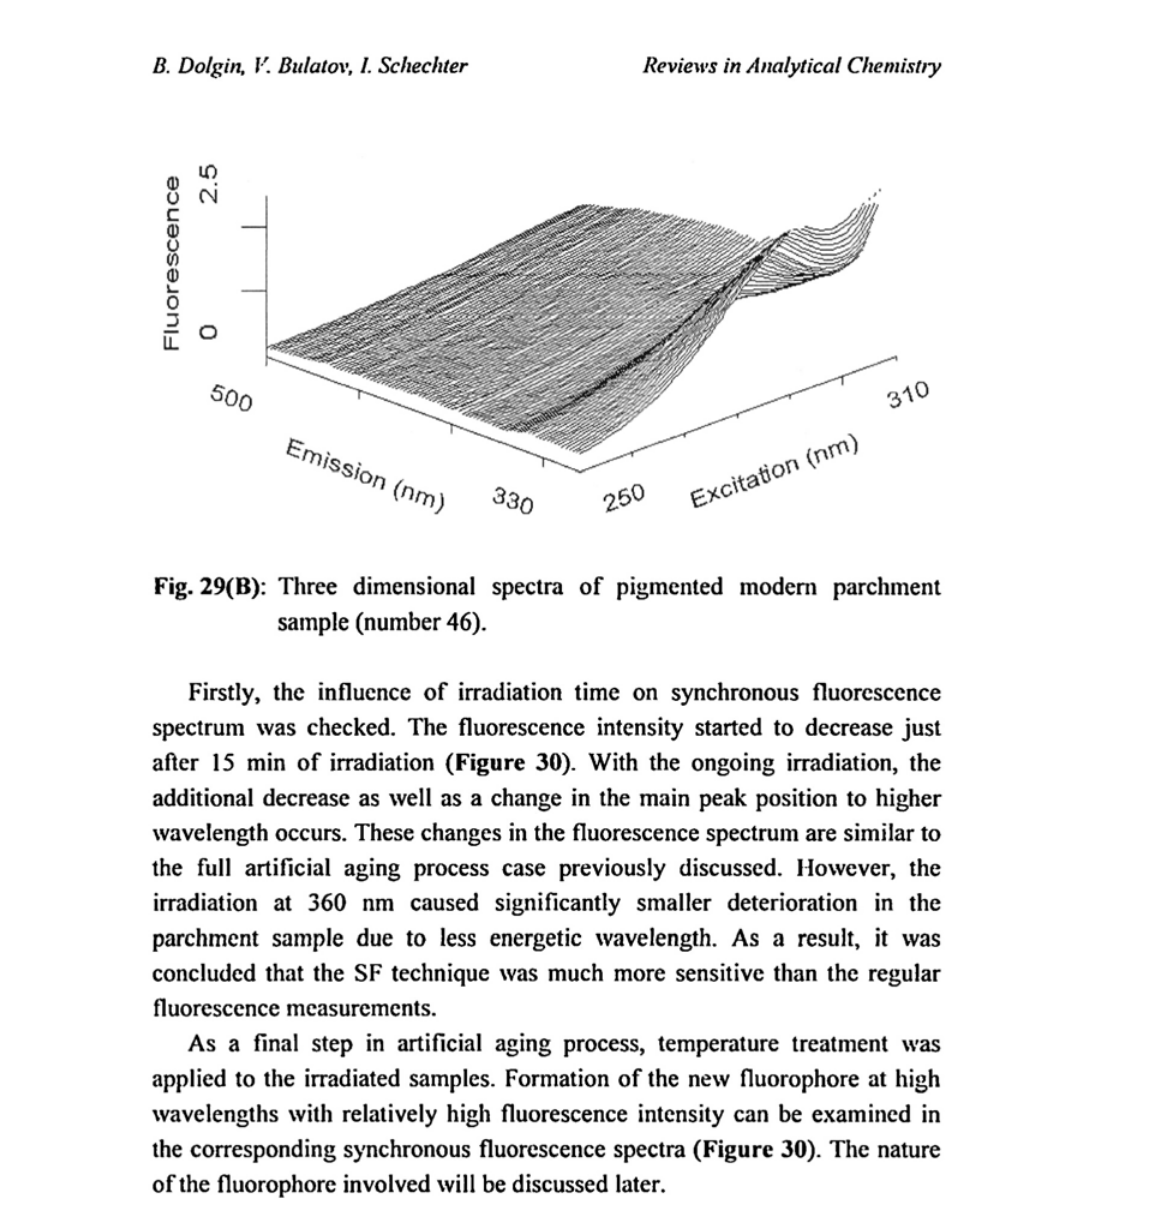
Fig. 29(B): Three dimensional spectra of pigmented modem parchment sample (number